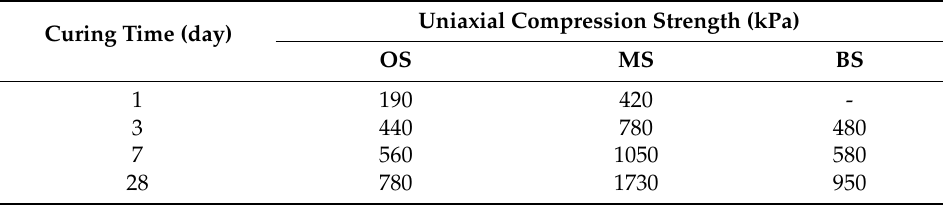
Figure 5. Uniaxial compression strength graphs for OS, MS and BS containing sodium silicate No. 3. Table 3. Uniaxial compression strengths of OS, MS and BS containing sodium silicate No. 3